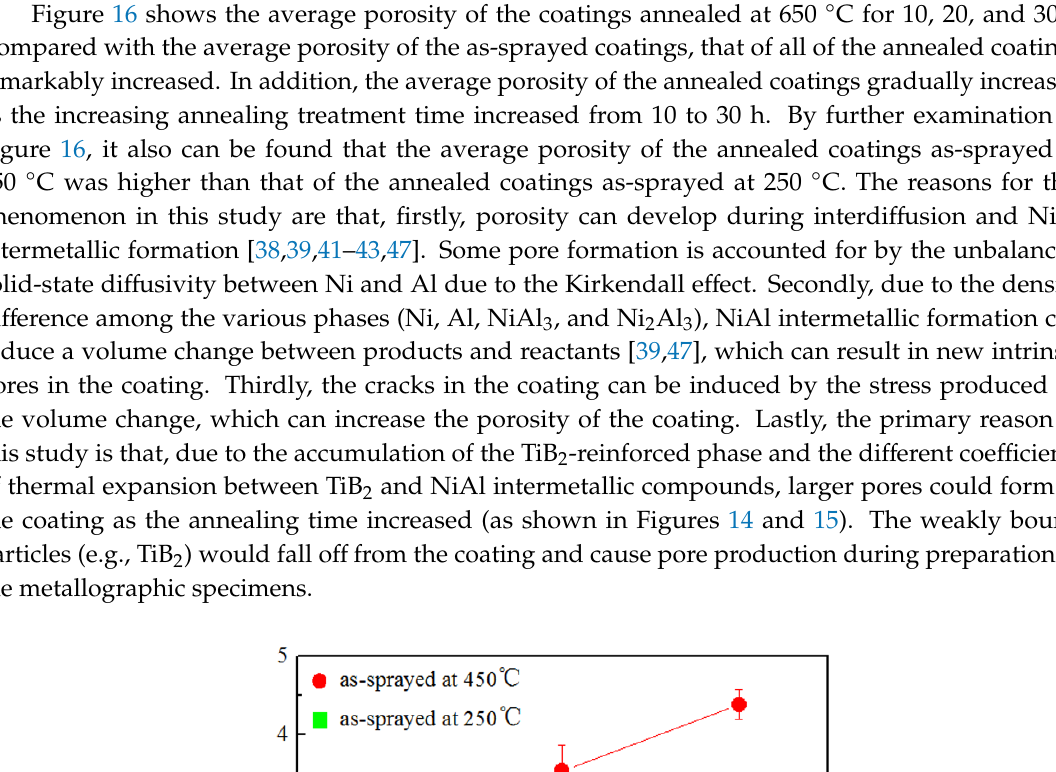
Figure 16. The porosity of the annealed Ni/Al-TiB 2 coatings at different annealing times.